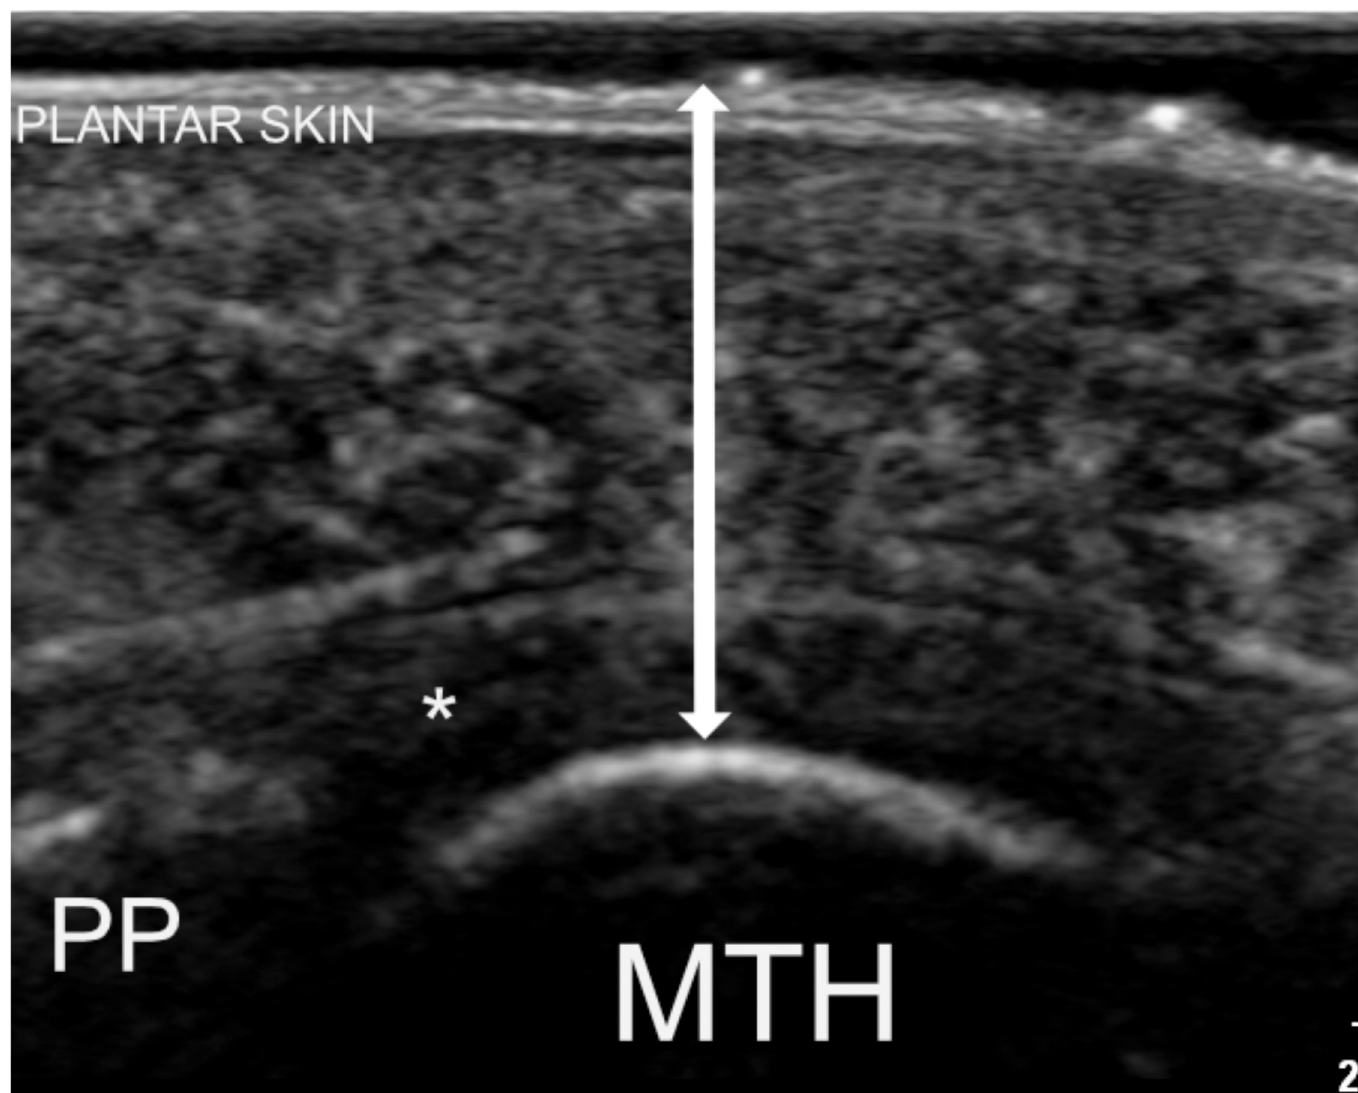
Fig 2. Longitudinal ultrasound image overlying the second metatarsal head demonstrating transducer positioning and measurement location (line with arrows). MTH; metatarsal head, PP; proximal phalanx, asterisk; plantar plate.